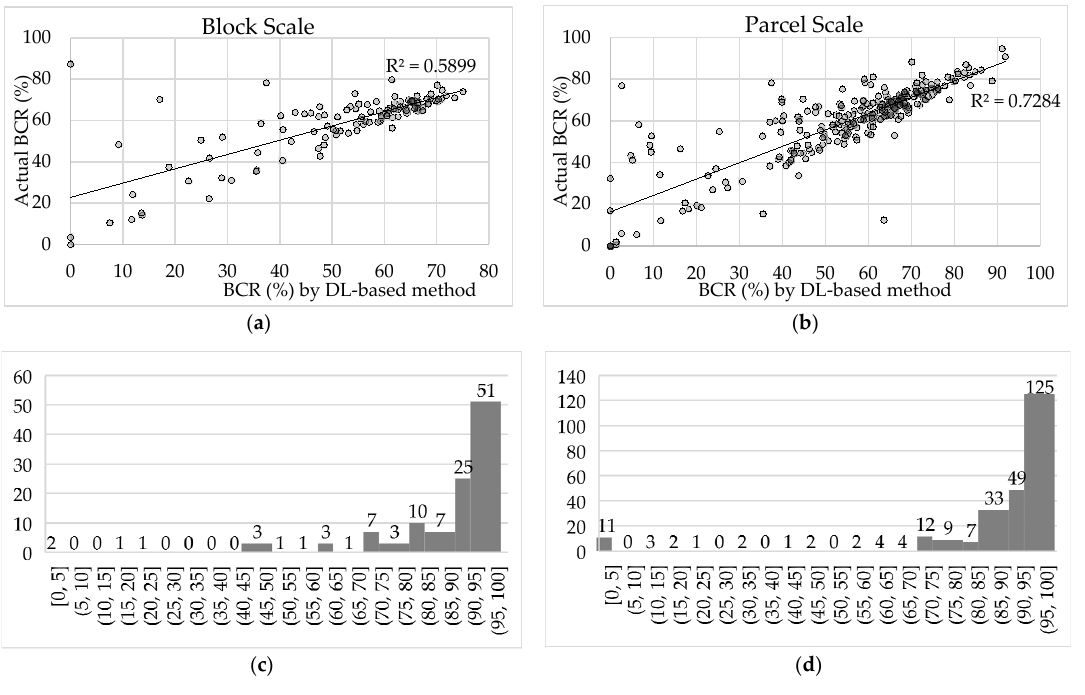
Figure 6. The fitting effect between BCR calculated using the DL-based method and the ground truth data ( a ) at the block scale, and ( b ) at the parcel scale. Accuracy distribution at ( c ) the block scale, and ( d ) the parcel scale. Table 4. The accuracy of BCR by DL.